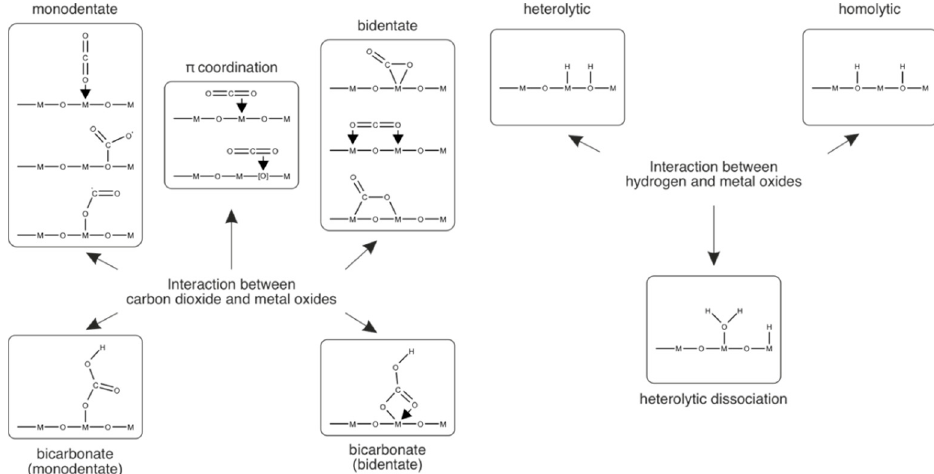
Figure 6. Different modes of the interactions of the CO 2 ( left ) and H 2 ( right ) reactants in methanation on stoichiometric and non-stoichiometric metal oxides. C—carbon, O—oxygen, [O]—oxygen vacancies, M—metal. According to [6].